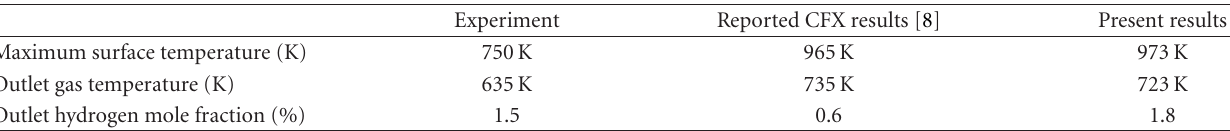
Table 2: Comparison of results for second steady-state condition (At inlet mixture temperature 373 K, mole fraction of hydrogen 8%, and mole fraction of steam 60% steam) for Gx-test series.